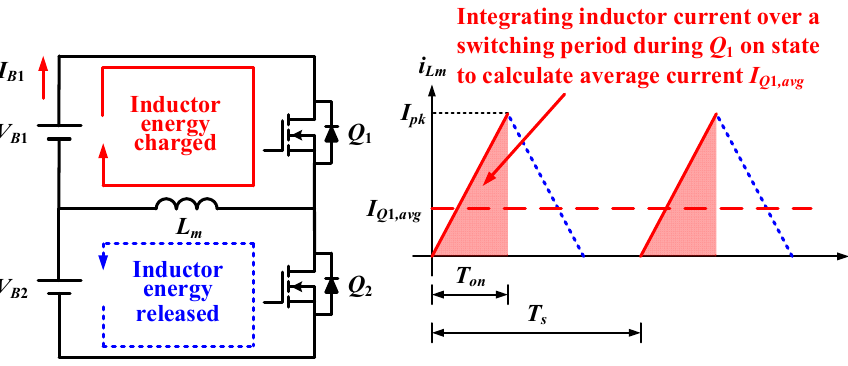
Figure 5. Circuit diagram and waveform of inductor currents.